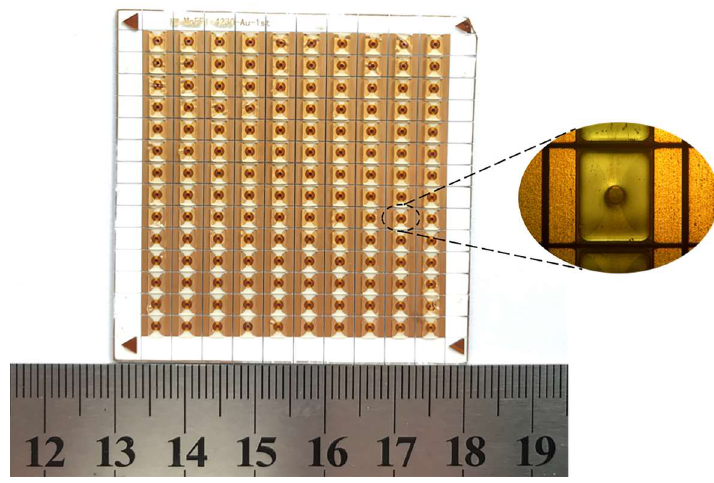
Figure 2. Samples of the McEFI after scribing.